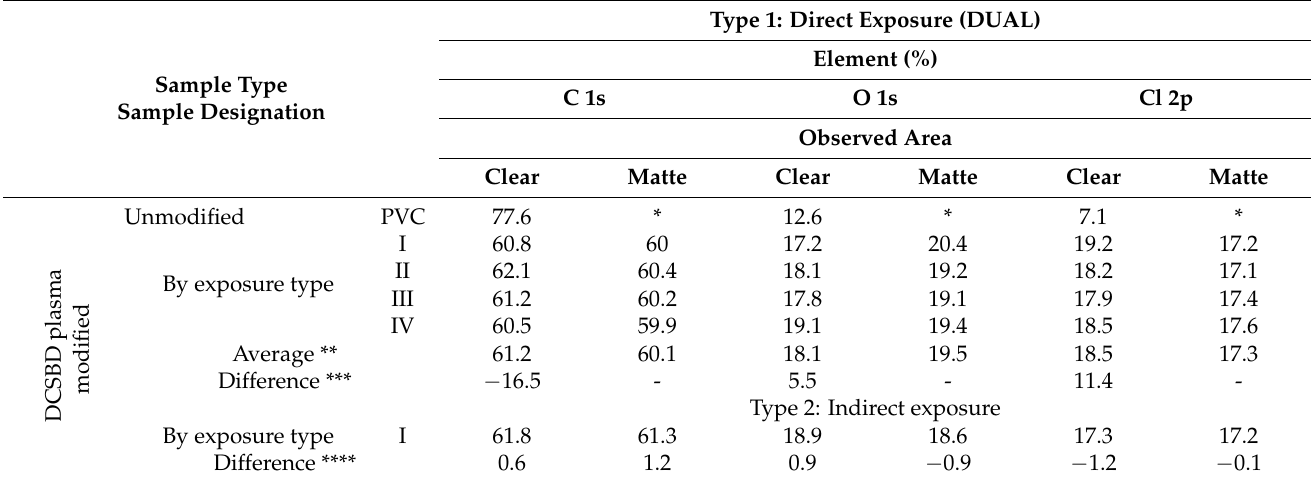
Table 3. Representation of elements on selected samples/types of